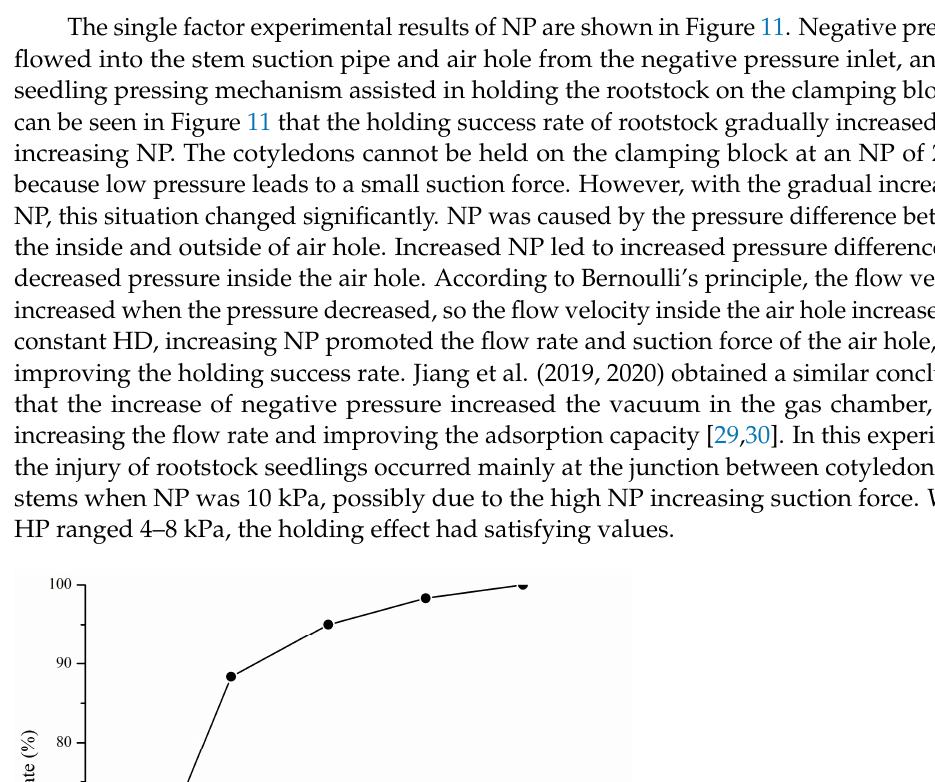
Figure 10. Relationship between hole diameter (HD) and success rate. Note: negative pressure (NP) was 4 kPa and inclination angle (IA) was 20 ◦ .